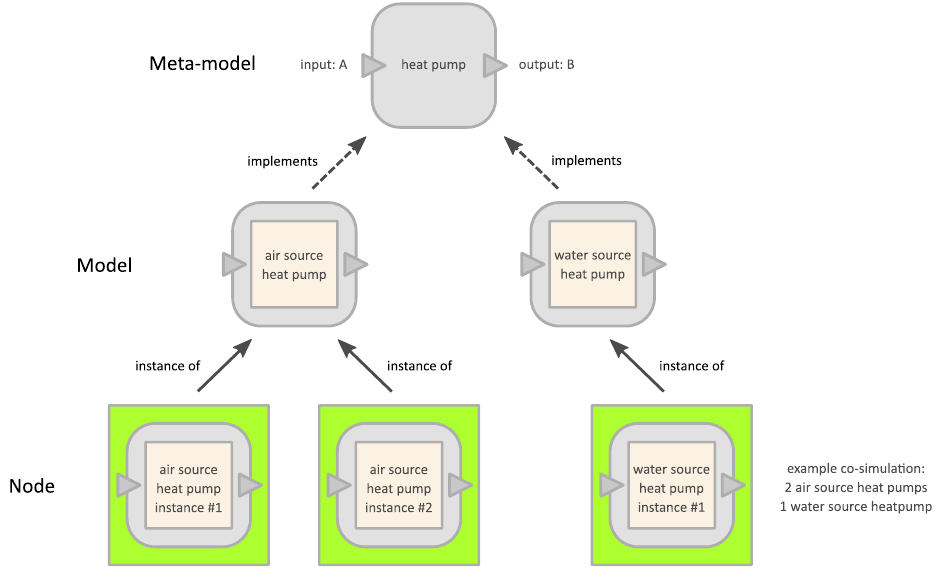
Figure 2. Overview of the relation between meta-models, models and nodes in the IntegrCiTy co-simulation